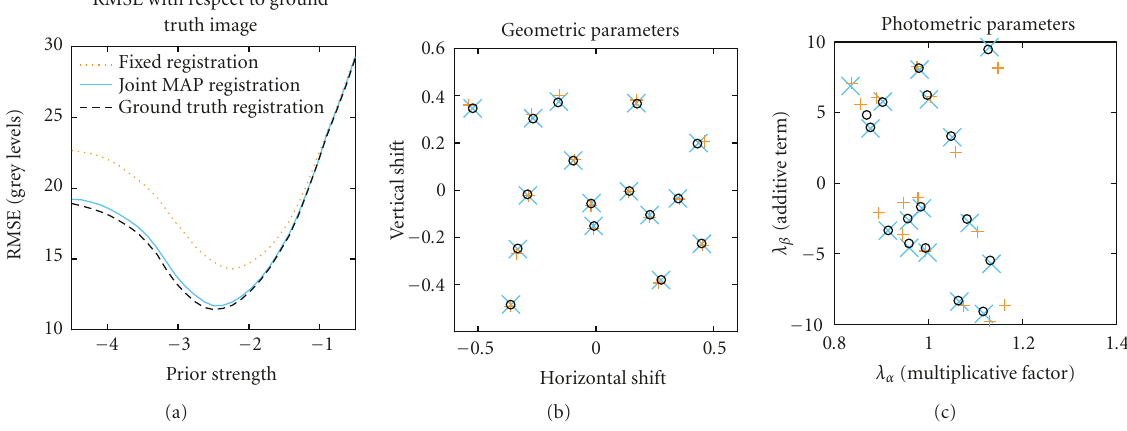
Figure 4: Synthetic data plots. (a) RMSE compared to ground truth, plotted for the fixed and joint MAP algorithms, and for the Huber super-resolution image found using the ground truth registration. (b), (c) plots showing the registration values for the initial (orange “+”), joint MAP (blue “ × ”) and ground truth (black “ ◦ ”) registrations. In most cases, the joint MAP registration value is considerably closer to the true value than the initial “fixed” value is.